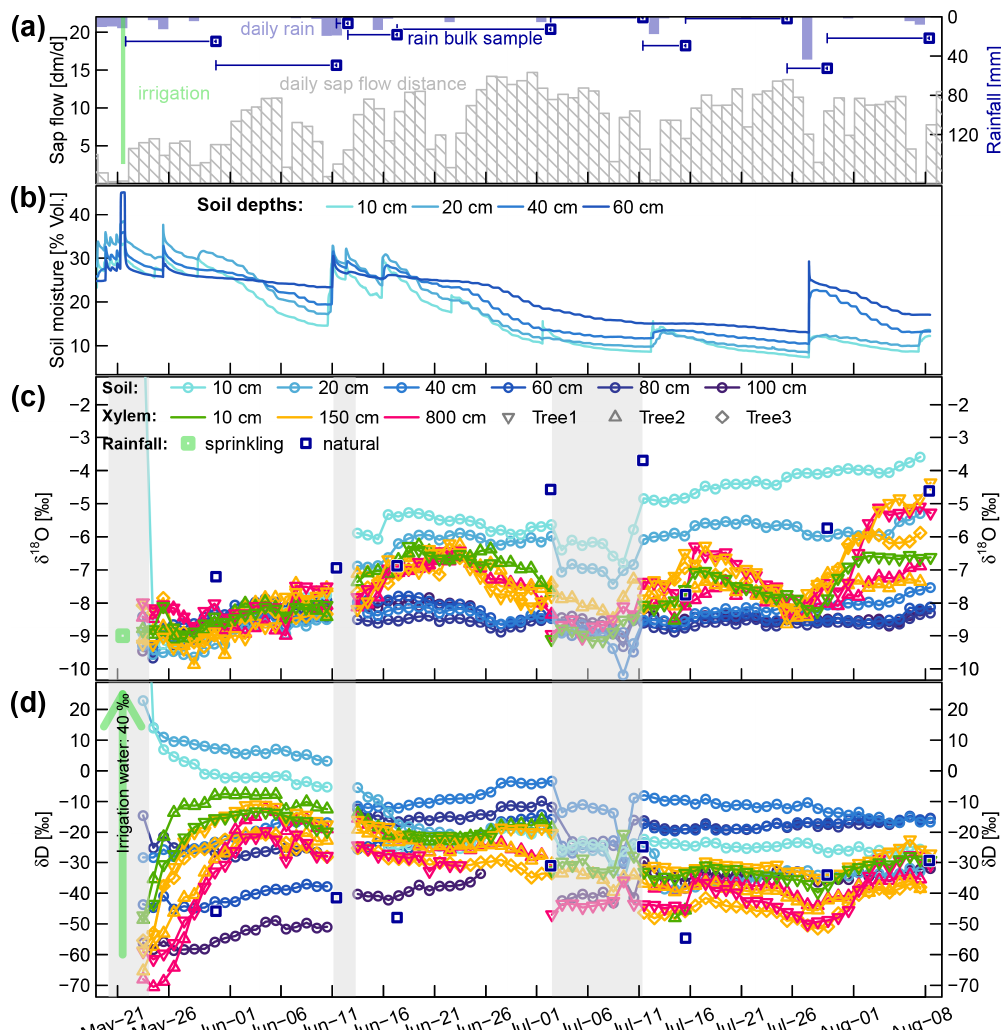
Figure 4. (a) Daily rainfall and cumulative sap flow distances. Dark blue squares represent the mean rainfall amounts collected with the four bulk samplers (dark blue lines indicating the periods over which the bulk samples were collected). (b) Volumetric soil moisture at four soil depths. ( c and d ) Corrected time series of δ soil and δ xyl in liquid water. The blue squares represent the mean isotopic signatures of the four bulk samplers. The translucent grey areas in ( c and d ) mark time periods with missing or unreliable isotope